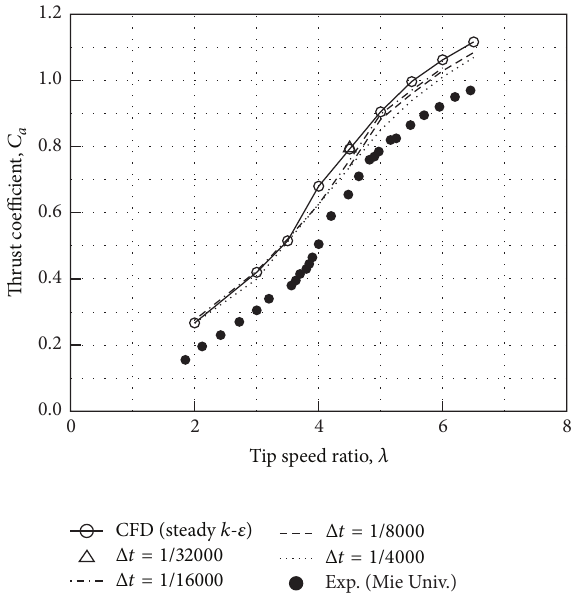
Figure 5: Thrust coefficient compared with experimental